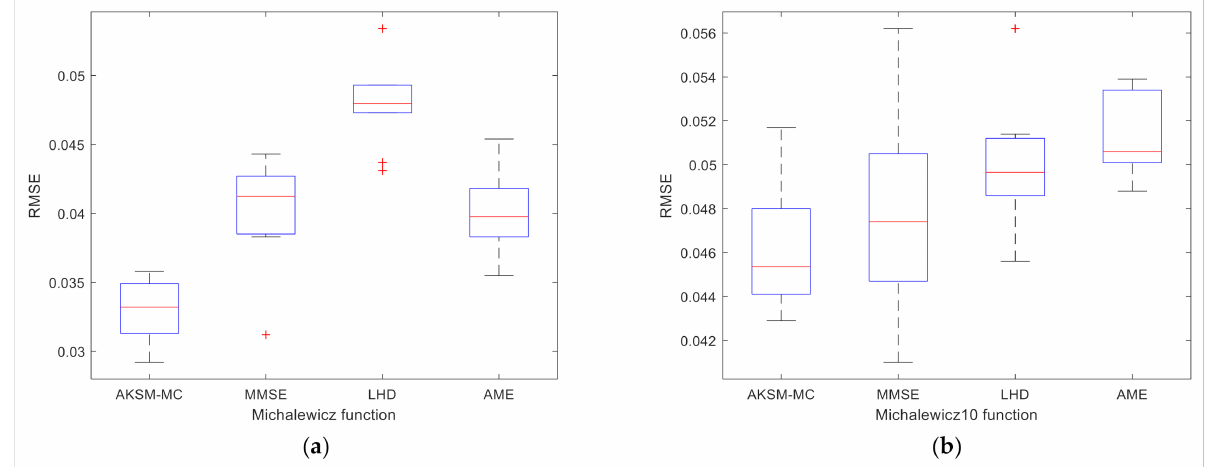
Figure 12. ( a ) Box plot of test results for Michalewicz function; ( b ) Box plot of test results for Michalewice10